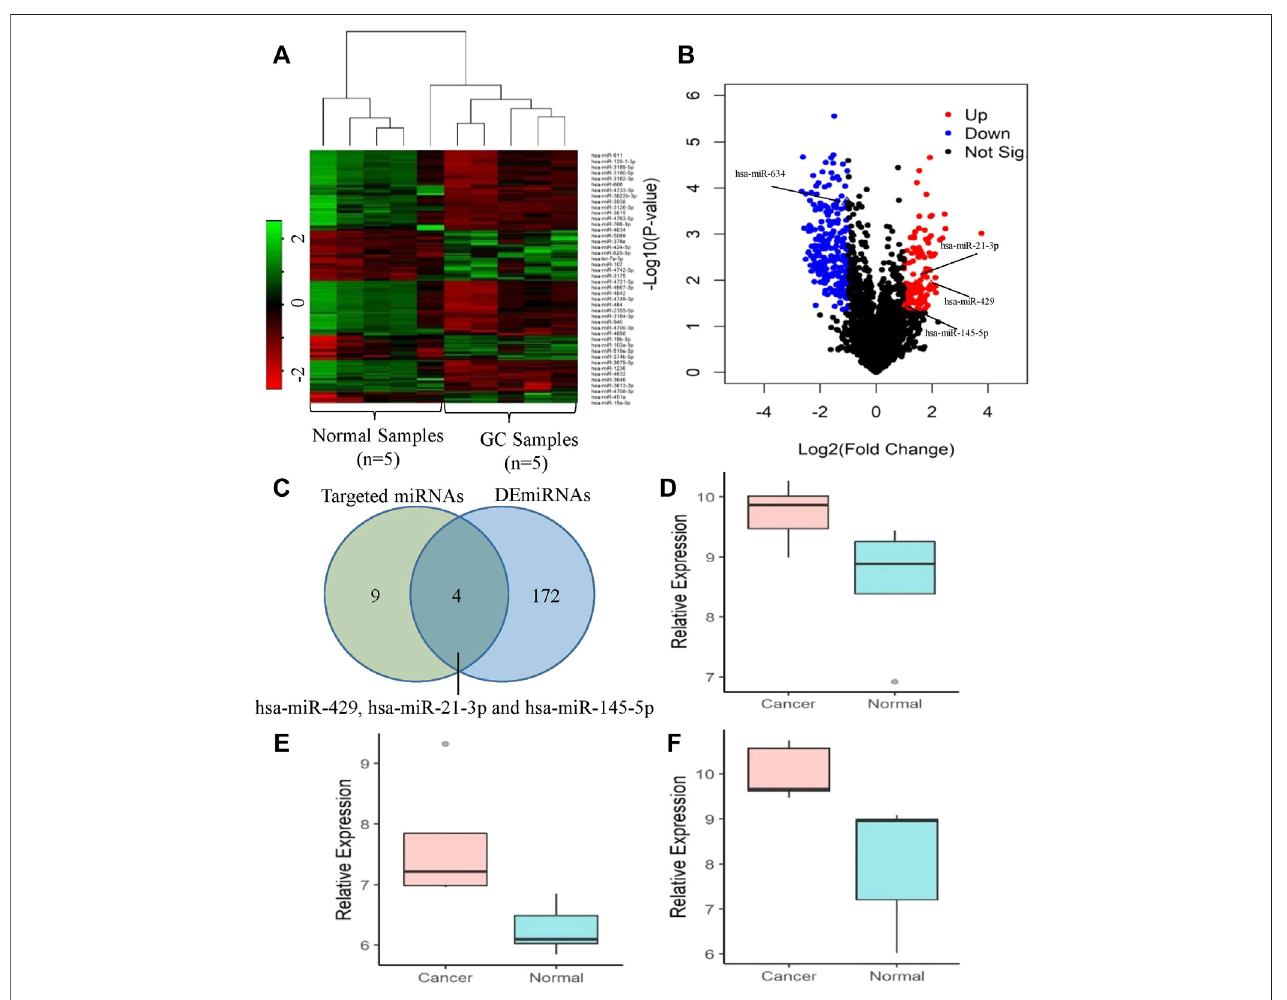
FIGURE6| ExpressionanalysisofthetargetedmiRNAsofthecircRNAscircCEACAM5 andcircCOL1A1. (A) Clusteredheatmaprepresentstheexpressionpro fi le of the DE miRNAs in GC compared to normal tissues. The color scale indicates the Log2FoldChange of the expression value for each miRNA in cancers vs normal tissues. Red color implies down-regulation while green color indicates up-regulation. (B) Volcano plot of the DE miRNAs in GC relative to normal tissues. Red, blue and black dots indicate up-regulation, down-regulation and not signi fi cant respectively. (C) Identi fi cation of the potential target miRNAs of the circRNAs circCEACAM5 and circCOL1A1. Expression levels of (D) hsa-miR-429, (E) hsa-miR-21-3p and (F) hsa-miR-145-5p in GC compared to normal tissues.